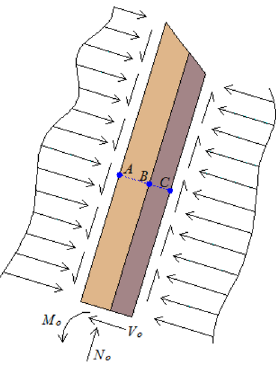
Figure 4. Stress state diagram of adjacent soft and hard rock stratum.